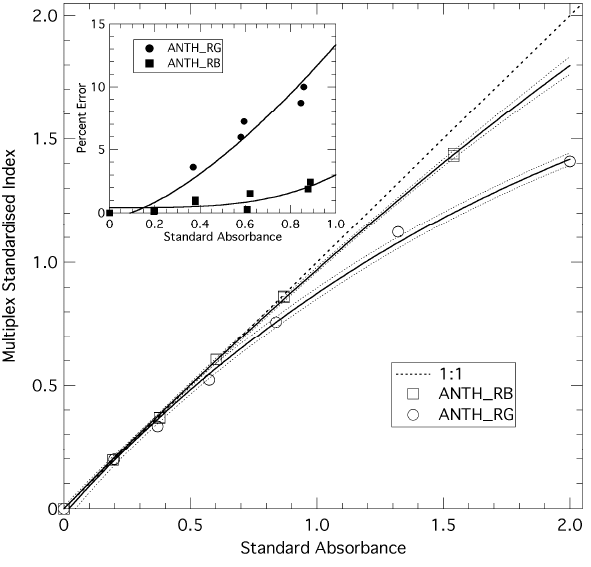
Figure 3. Calibration of the anthocyanins-related Multiplex ® indices using standards of known absorbance. Multiplex ® indices ANTH_RB and ANTH_RG were calculated from their respective signals [Equations (1) and (2)] and plotted on the y-axis. Best exponential fits (full lines) and 95%-confidence intervals of the fit (broken lines) are shown. Insert: percent error (difference) between standard absorbance and Multiplex ® derived